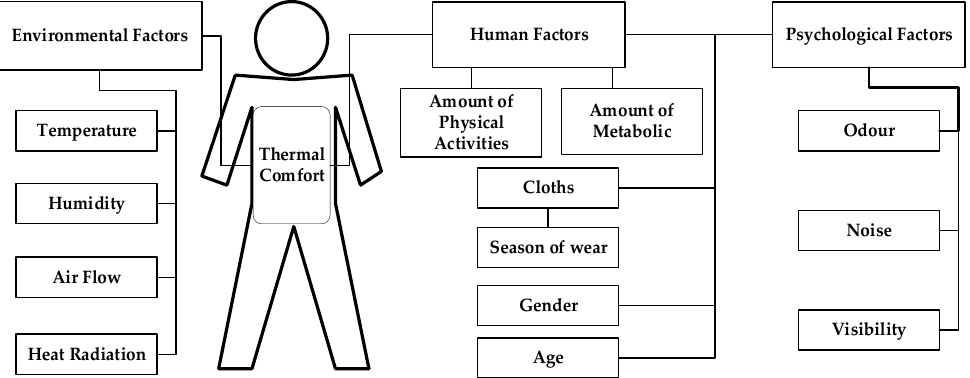
Figure 5. Categorization of different thermal comfort factors [126,127].